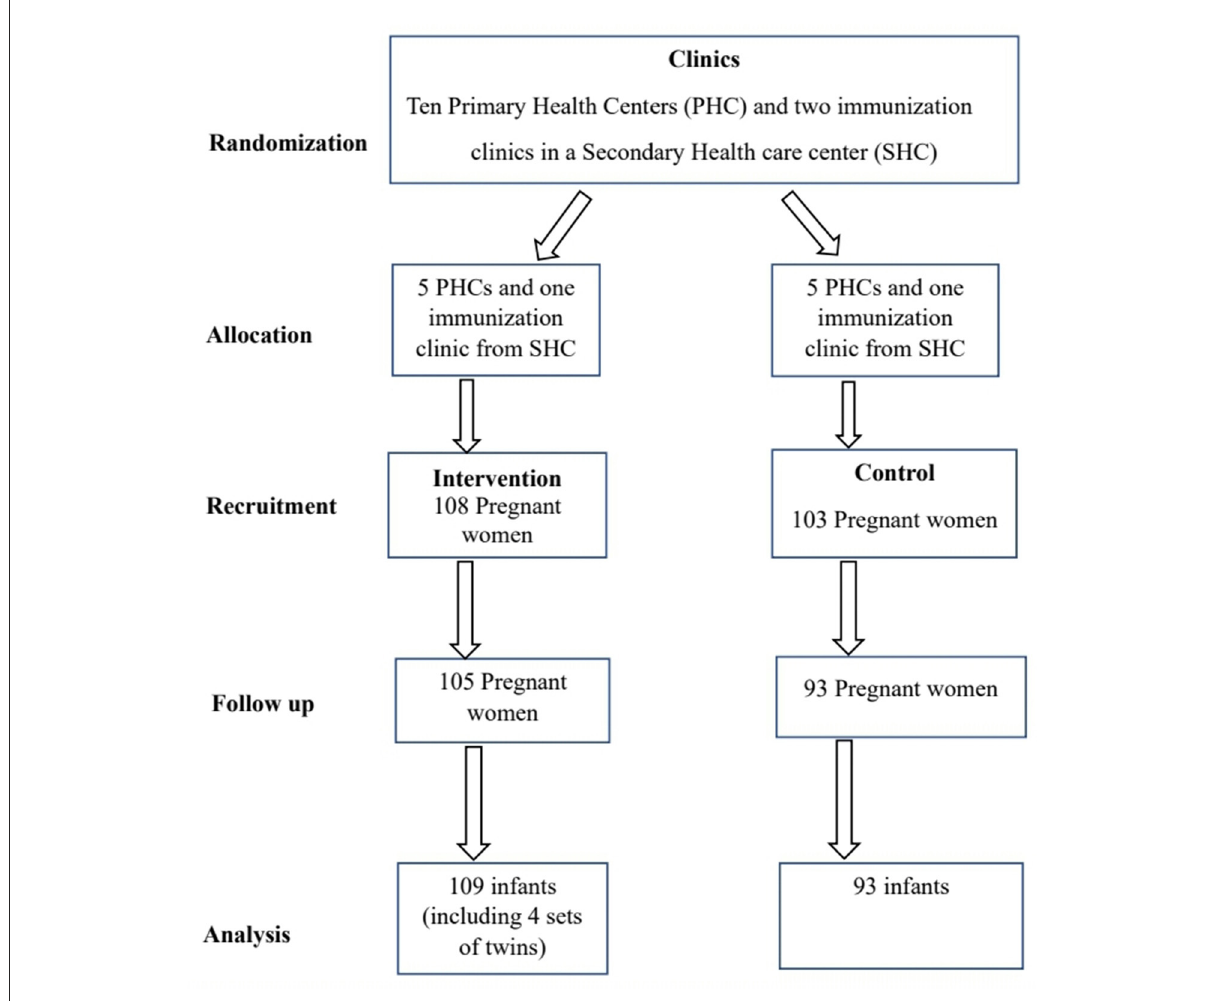
FIGURE1 Flow of study